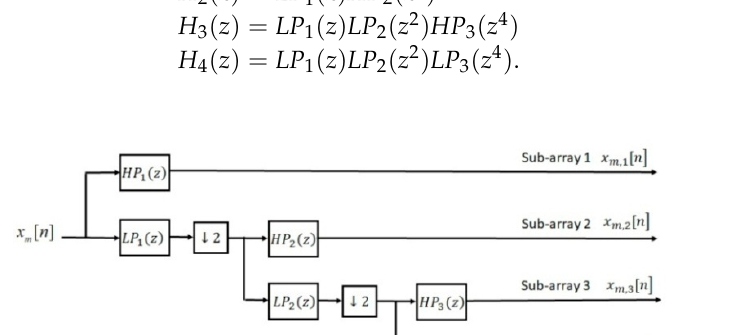
Figure 4. The frequency response for the analysis filter banks.